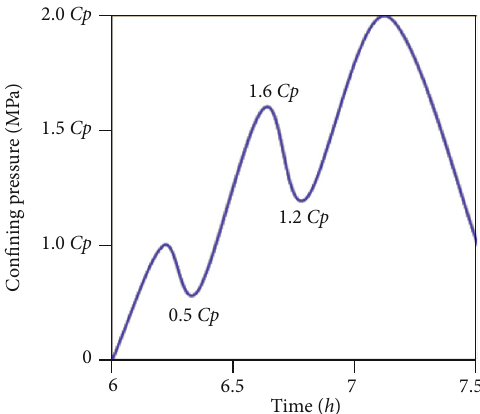
Figure 3: Schematic of the preconsolidation loading of the oil sand specimens ( C p is the e ff ective con fi ning pressure during the triaxial